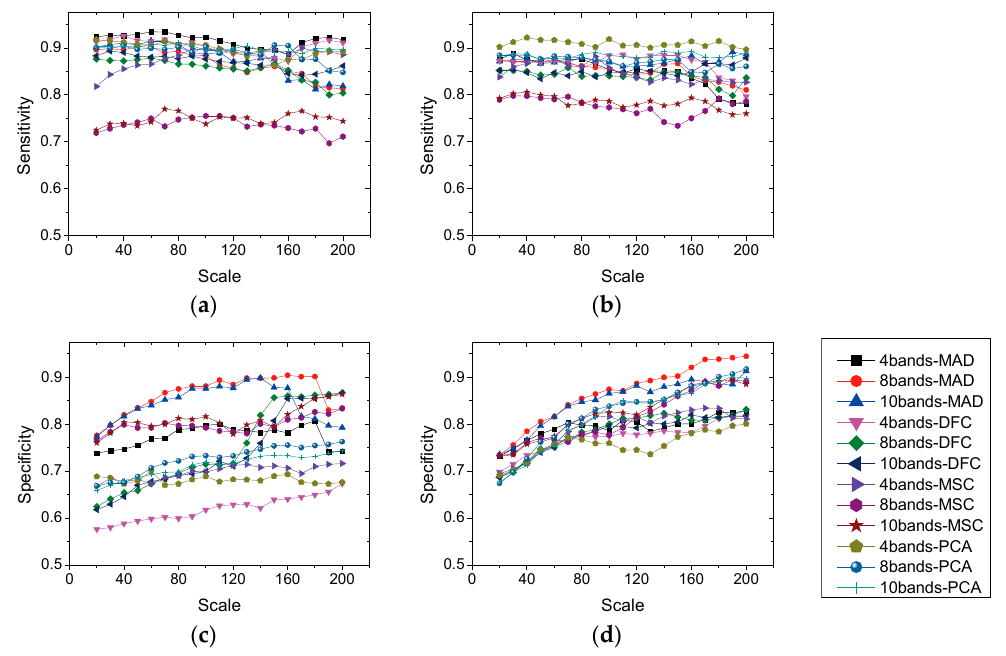
Figure 6. Sensitivity and specificity at each segmentation scale using four change detection methods and three segmentation strategies, for both study sites: ( a ) sensitivity for Study site 1; ( b ) sensitivity for Study site 2; ( c ) specificity for Study site 1; ( d ) specificity for Study site 2. The value of the y -axis indicates the proportion of true positive/negatives, where 0 is completely inaccurate, while 1 is completely accurate.